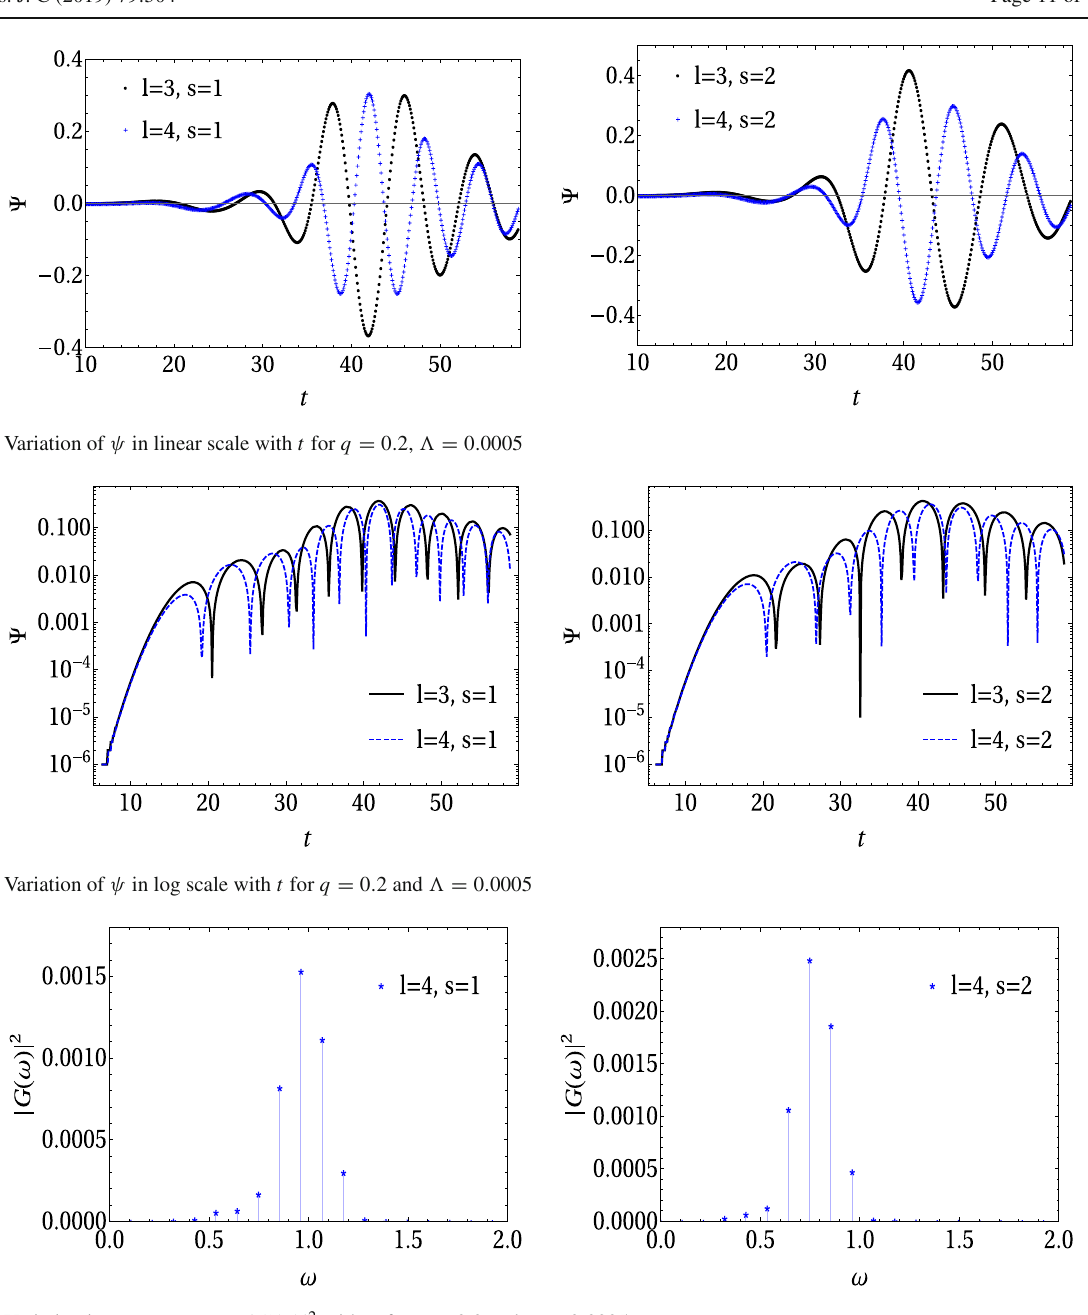
Fig. 14 Variation in power spectrum | G (ω) | 2 with ω for q = 0 . 2 and (cid:2) = 0 .